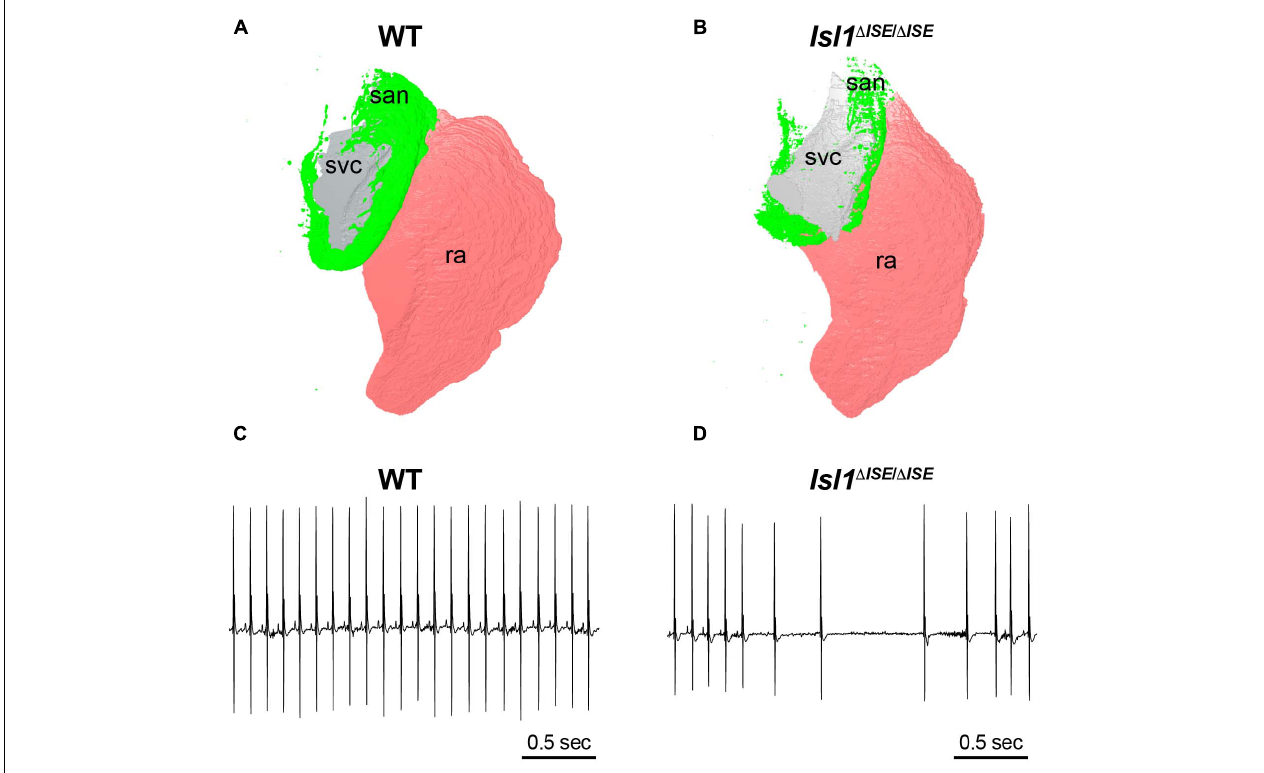
FIGURE 4 | Sinoatrial node hypoplasia and dysfunction after deletion of a key pacemaker cell-specific enhancer. (A) Three-dimensional reconstruction of light sheet fluorescence image of Hcn4 + sinoatrial node (san, green), right atrium (pink, ra) and superior vena cava (gray, svc) from a WT control adult heart (left) in comparison to (B) a heart obtained from a littermate lacking both copies of an SAN-specific enhancer (ISE) for the transcription factor Isl1 . Hearts were stained in whole mount with Hcn4 antibody and san, ra, and svc were manually segmented. Note the markedly reduced size of the Hcn4 + SAN in the Isl1 (cid:49) ISE /(cid:49) ISE heart. (C) Electrocardiograms recorded from a WT control adult mouse (left) and (D) an Isl1 (cid:49) ISE /(cid:49) ISE littermate demonstrate an example of sinus arrhythmias in animals lacking the Isl1 enhancer.